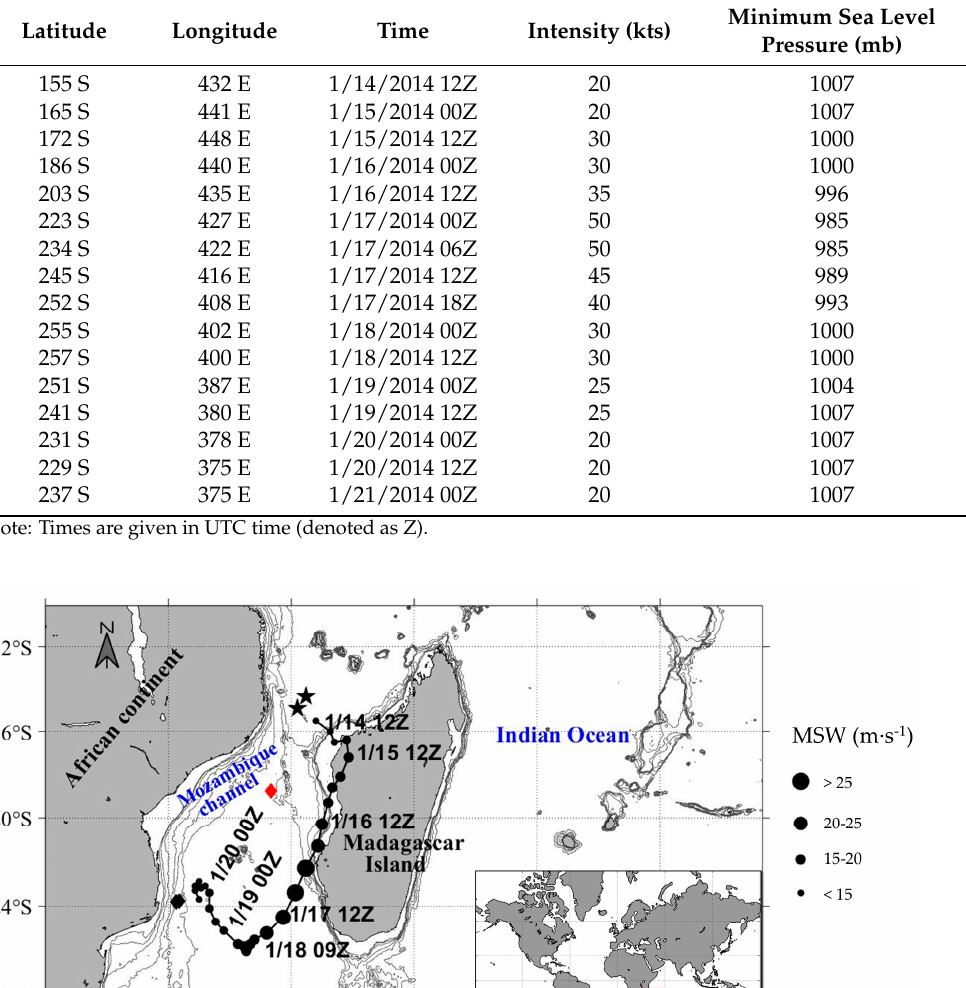
Table 1. Position, time and intensity of TS Deliwe.